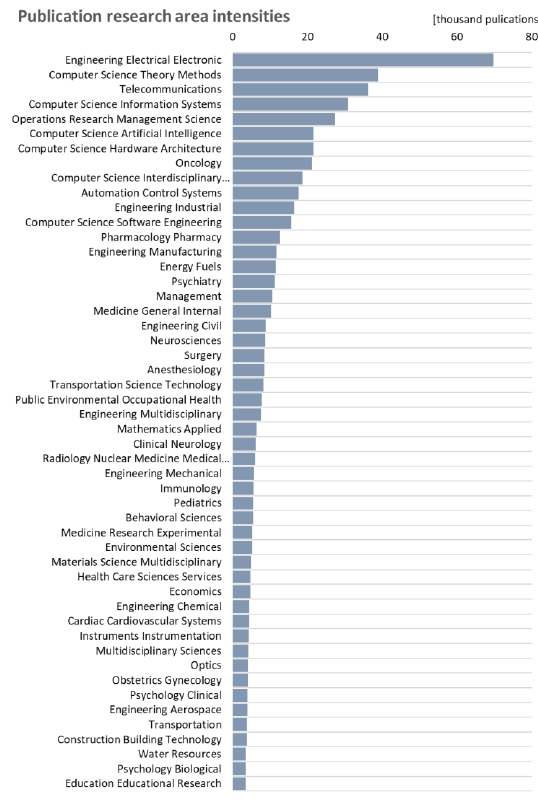
Figure A1. Publication research area intensities. Source: authors according to data of Web of Science Core Collection.